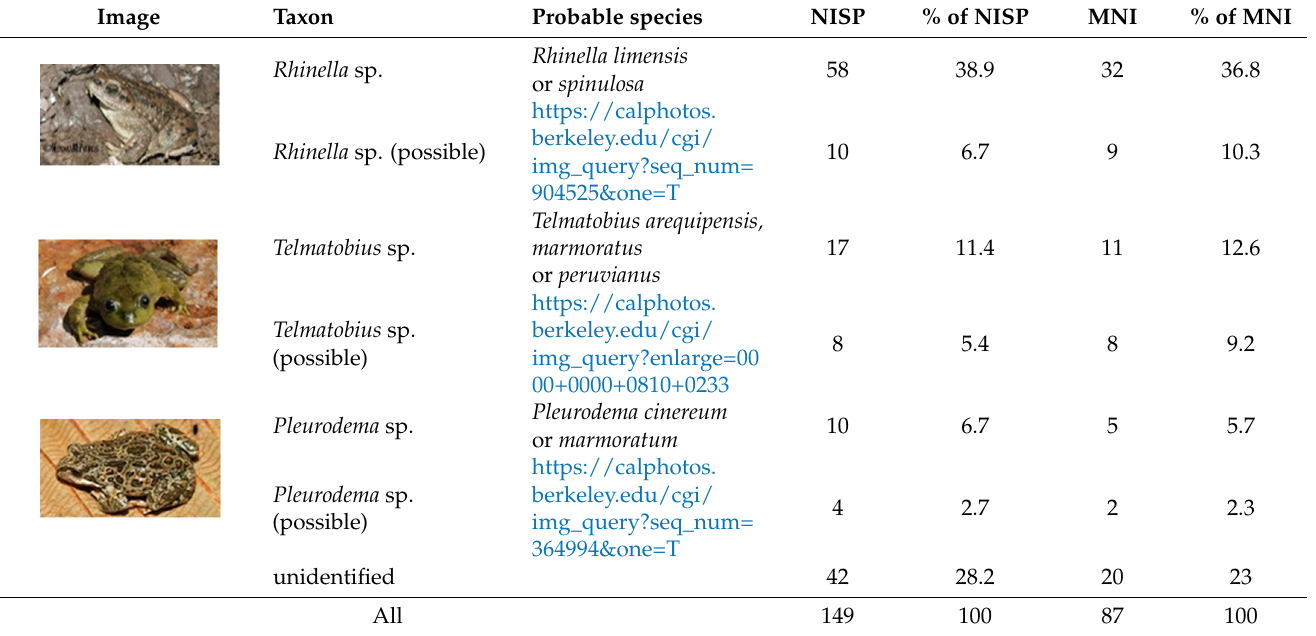
Figure 4. Humeri of anuran species used for comparison with fossil material. ( a ) Telmatobius carrillae ; ( b ) Rhinella marina ; ( c ) Pleurodema nebulosa; ( d ) Hyla boans ; ( e ) Gastrotheca nebulanastes ; ( f ) Psychro- phrynella bagrecito . ( a – e ) Right humerus, scale bar = 5 mm; ( f ) left humerus, scale bar = 2 mm. [51] (Anatomical nomenclature). Composite image by Vallejo-Pareja from photographs of digitally seg- mented specimens (ct-scans) at the Herpetology Division of the Florida Museum of Natural History. (photos reproduced with permission: Rhinella sp. [54], Telmatobius sp. [55], and Pleurodema sp. [56]). Table 2. Number of Anura humeri from M70-2961 identified to the genus level by NISP and MNI